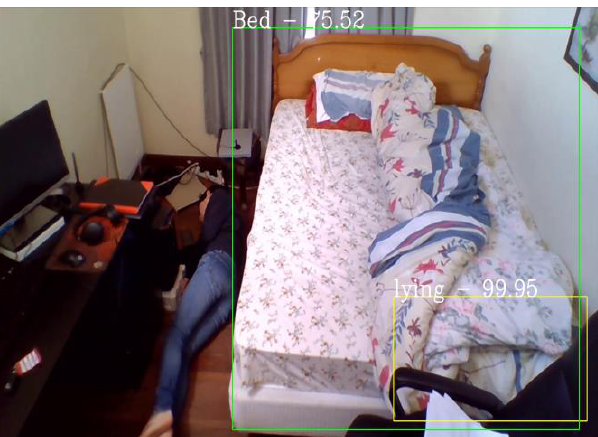
Fig. 7. Example of a failed